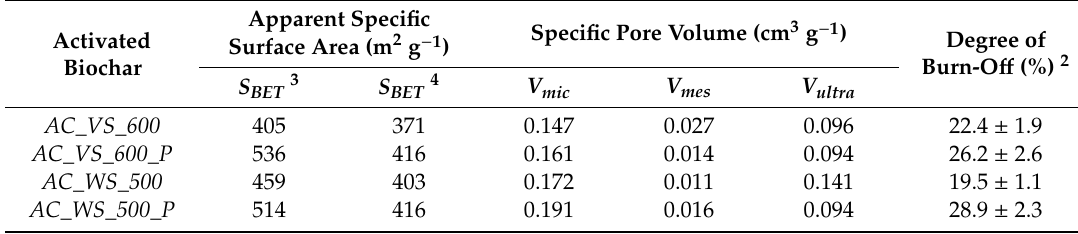
Table 3. Main textural properties and degrees of burn-o ff of activated biochars.